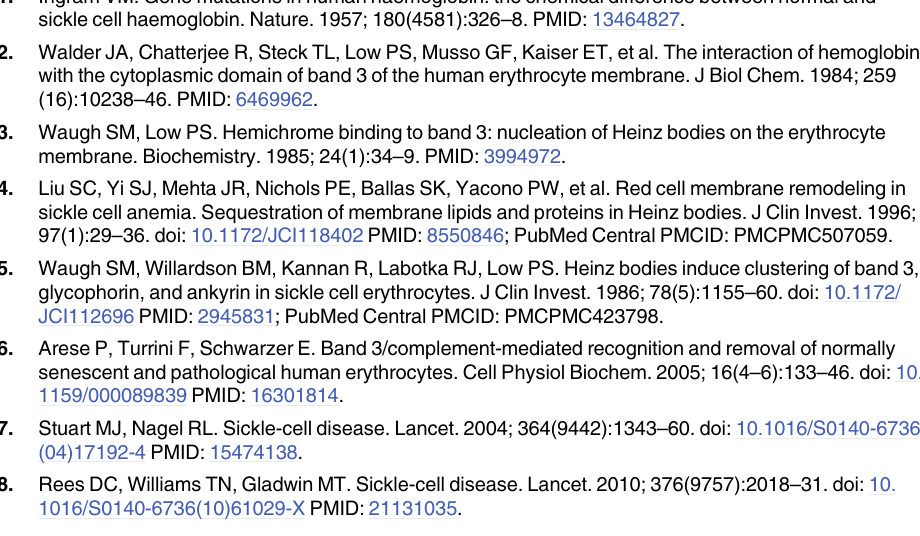
S1 Fig. Distribution of individual diffusion coefficients of reversibly sickled cells (RSC). S2 Fig. Distribution of individual diffusion coefficients of irreversibly sickled cells